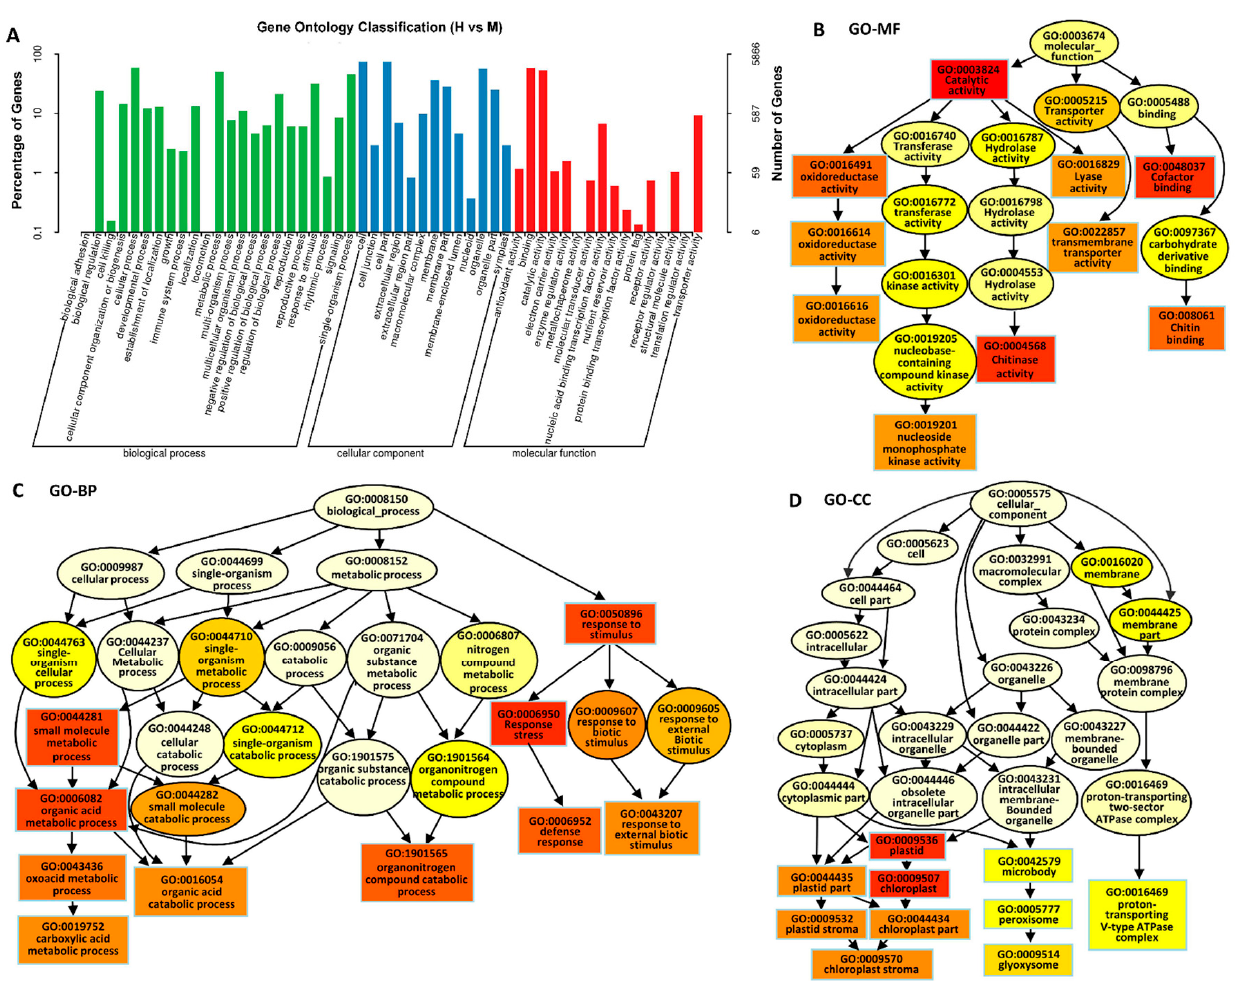
Figure 3. Functional annotation of DEGs based on gene ontology categorization. ( A ) GO enrichment analysis of DEGs. The DEGs were categorized into three main categories, Molecular Functions (MF), Biological Processes (BP), and Cellular Components (CC). ( B – D ) The functional categories of DEGs in MF ( B ), BP ( C ), and CC ( D ), respectively. Rectangles/circles contain the GO term number and category name. Rectangle and oval colors represent the relative significances, ranging from red (the most significant, p < 0.0001), orange (the second significant, p < 0.001), yellow (the third significant; p < 0.01) to light yellow (the least significant, p < 0.05).